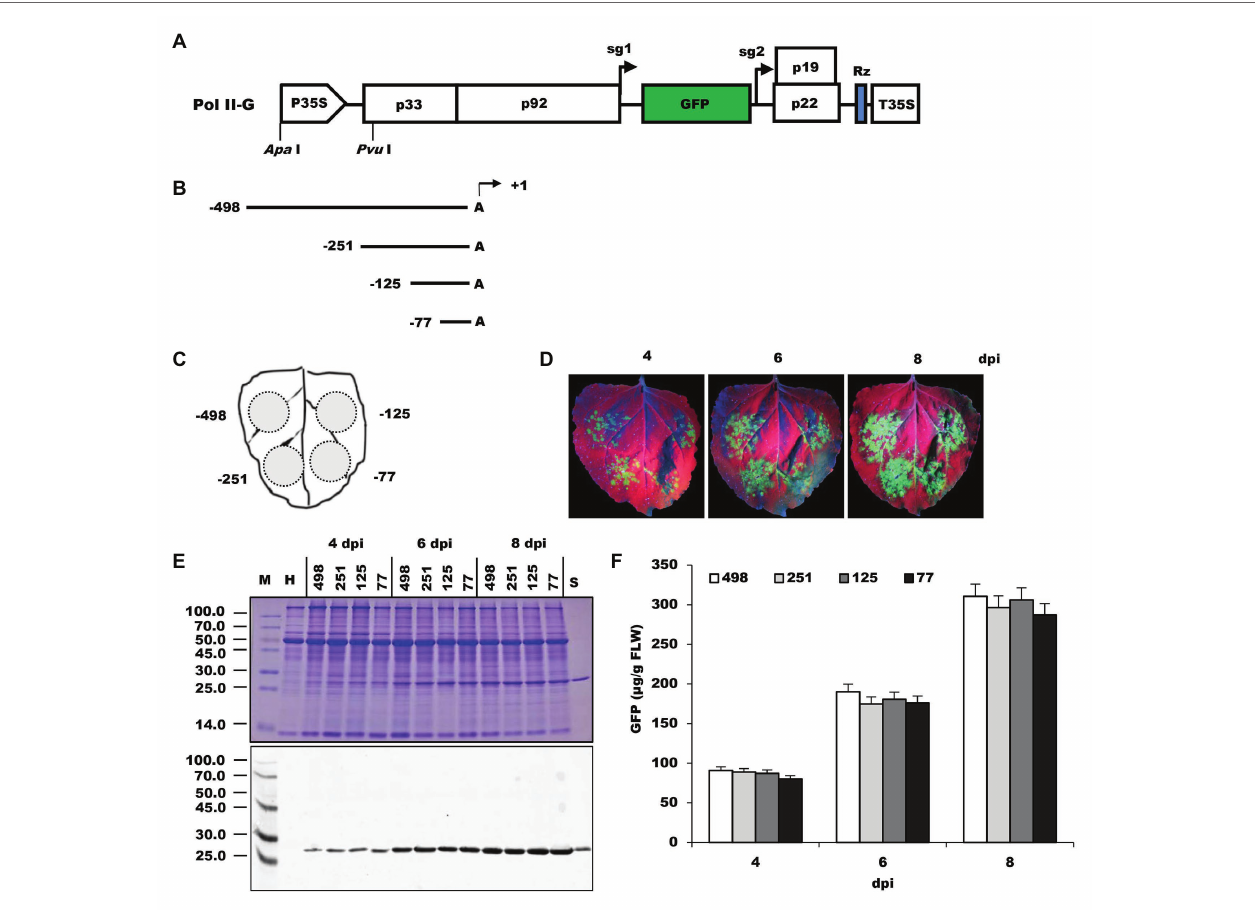
FIGURE 1 | Comparison of Nb rRNA gene promoter deletion constructs for their ability to express GFP in N. benthamiana leaves. (A) Pol II-G, a GFP-expressing tomato bushy stunt virus (TBSV)-based viral vector under control of 35S promoter. It was used as a backbone to develop the deletion constructs of the N. benthamiana polymerase I promoter. P35S, 35S promoter; p33 and p92, the gene coding replication proteins; sg1 and sg2, the transcription initiation sites for subgenomic mRNAs 1 and 2 indicated by right-angled arrows; GFP, enhanced green fluorescent protein gene; p19, silencing suppressor gene; p22, cell-to- cell movement protein (MP) gene; Rz, ribozyme; T35S, CaMV polyA signal sequence/terminator; Apa I and Pvu I, restriction enzymes sites. (B) Summary of 5' deletion constructs of the N. benthamiana polymerase I promoter. Arrows denote positions at which transcripts are initiated (defined as +1). (C) Schematic representation of the agroinfiltrated zones in N. benthamiana leaf. (D) GFP expression pattern (under UV light) of agroinfiltrated N. benthamiana leaves at 4, 6, and 8 dpi, respectively. (E) SDS-PAGE analysis and immunodetection of proteins isolated from the agroinfiltrated zones of N. benthamiana leaves. The gel was stained with Coomassie brilliant blue (upper panel) and the corresponding antibodies were used to detect GFP (lower panel) in agroinfiltrated N. benthamiana leaves by Western blots. M, molecular weight marker (kDa); H, total soluble protein extracts from uninoculated leaves; 498, 251, 125, and 77, total soluble protein extracts from the corresponding agroinfiltrated zones of N. benthamiana leaves in (C) . (F) Time course for the accumulation of recombinant GFP protein in N. benthamiana leaves by